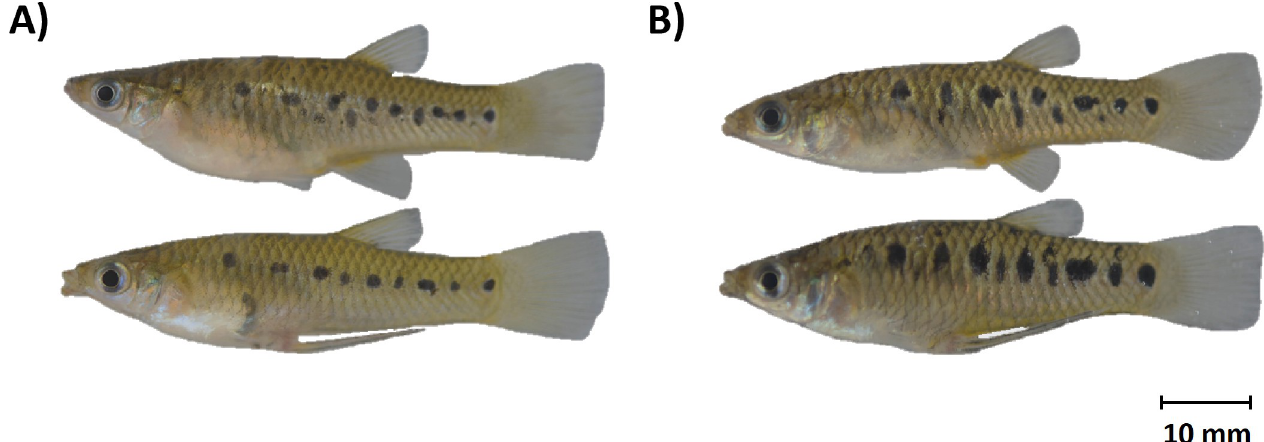
Fig 1. Images of Poecilopsis gracilis and Poeciliopsis pleurospilus . A) Female (upper) and male (lower) specimens of P . gracilis from the Rı´o Ajal in Oaxaca, Mexico. B) Female (upper) and male (lower) specimens of P . pleurospilus from the Rı´o Ostuta in Oaxaca,